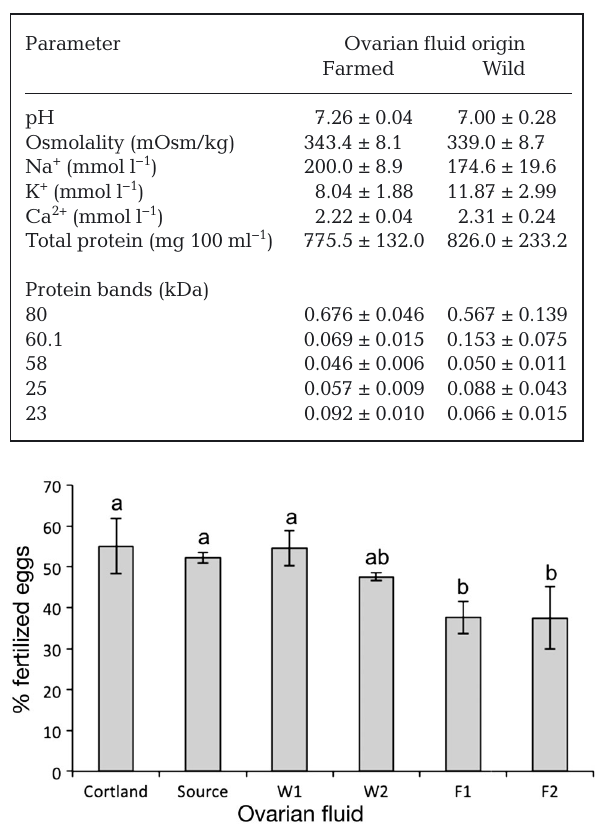
Table 1. pH, osmolality, ion concentrations (Na + , K + and Ca 2+ ), total protein concentrations and the proportion of the main protein bands for the ovarian fluids of wild and farmed females. Values are expressed as mean ± SEM